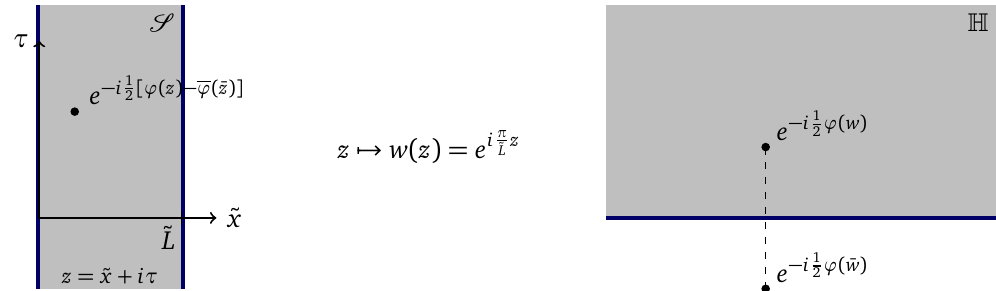
Figure 2: Infinite strip (cid:83) = [ 0, ˜ L ] × (cid:82) . It is mapped to the upper-half-plane (cid:72) by the conformal π z . It allows to exactly compute the normal ordered product on transformation z (cid:55)→ w ( z ) = e i ˜ L the plane (cid:67) using the method of